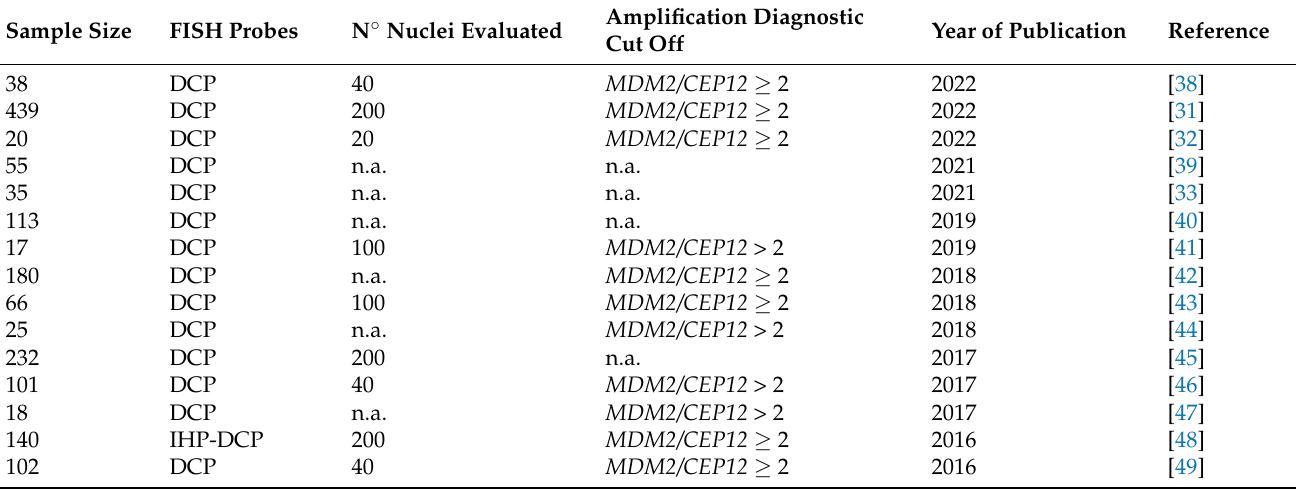
Table 2. Selection of the most relevant published studies evaluating FISH MDM2 amplification.